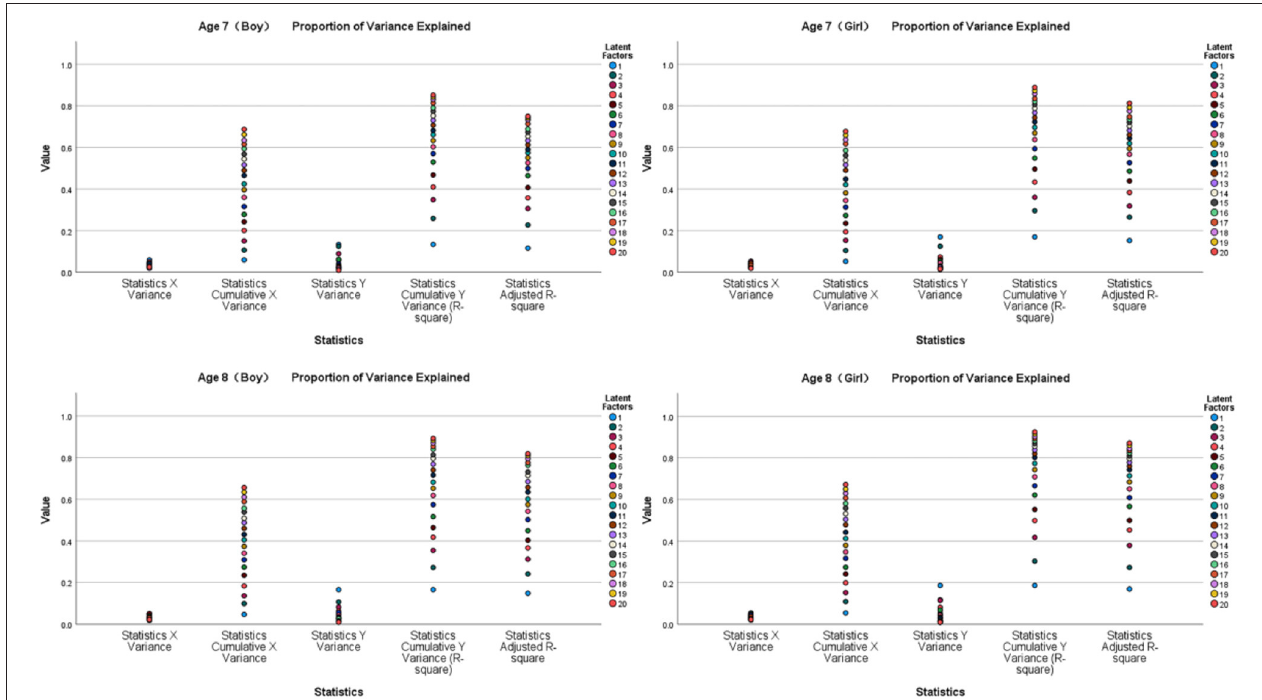
FIGURE 4 | Explanation and analysis of motor behavior on motor performance.